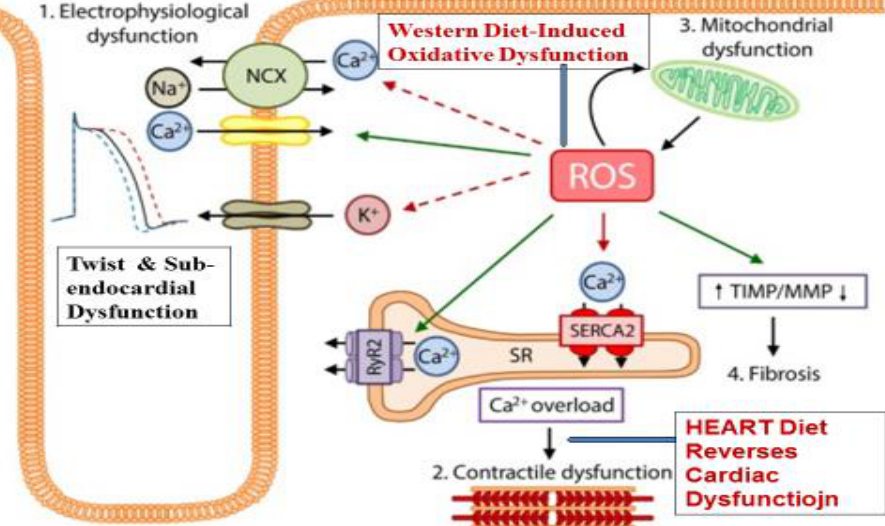
Figure 1. Oxidative dysfunction in the heart due to Western diet, with decrease in antioxidant defences, causing mitochondrial dysfunction, leading to electrophysiological dysfunction with twist and sub-endocardialdysfunction. Exogenous antioxidants (HEART diet) improve antioxidative function with reduced Ca overloading and reversal of mitochondrial and electrophysiological dys- function. (Modified from Reference [1], VanderPolA, Euro J Heart Failure 2019, under the license http://creativecommons.org/licenses/by-nc/4.0/., accessed on 15 June 2022).